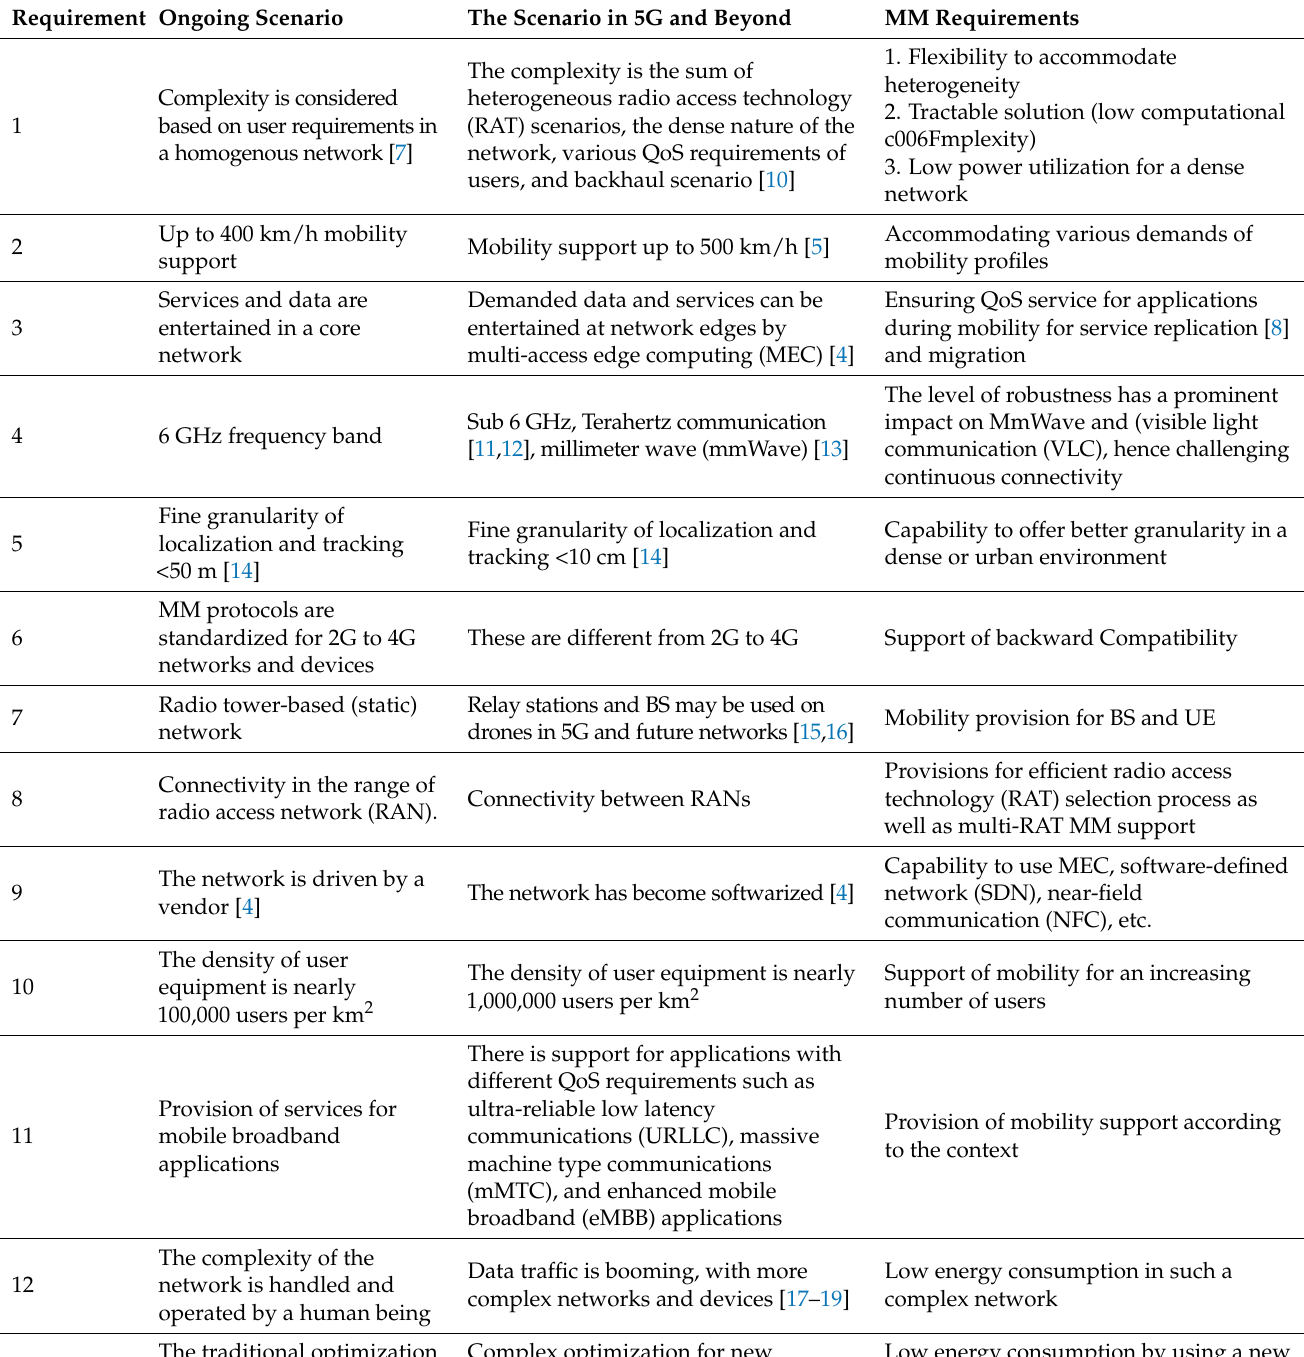
Table 1. Functional requirements of MM